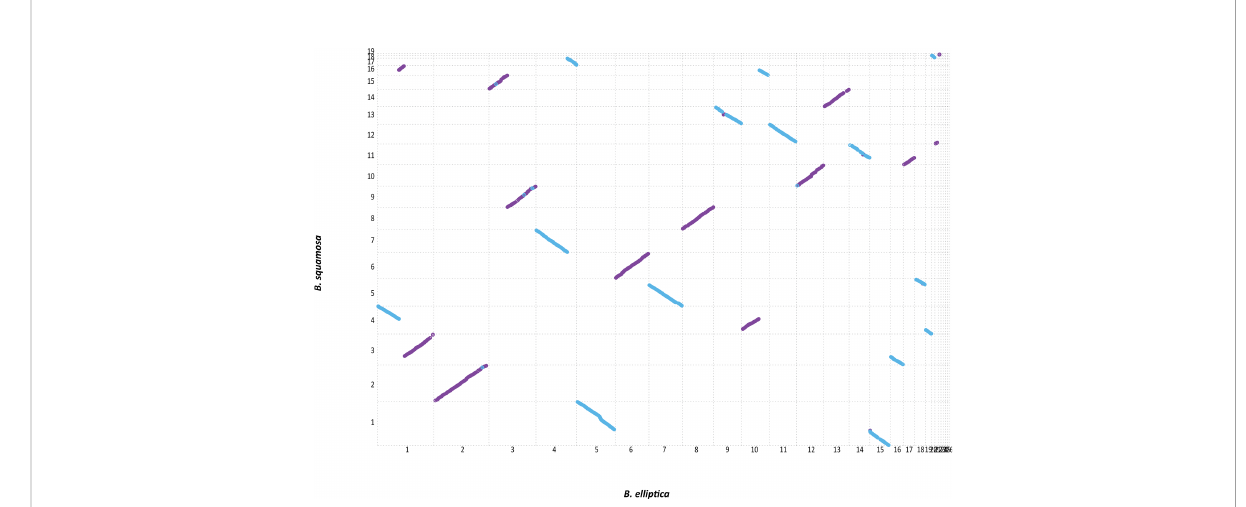
FIGURE 2 Synteny analysis of the genomes of B. elliptica and B. squamosa reveals a high level of synteny with few balanced structural rearrangements. Aligned contigs are color coded indicating the orientation of the synteny segments with purple indicating forward and blue indicating reverse orientation of the